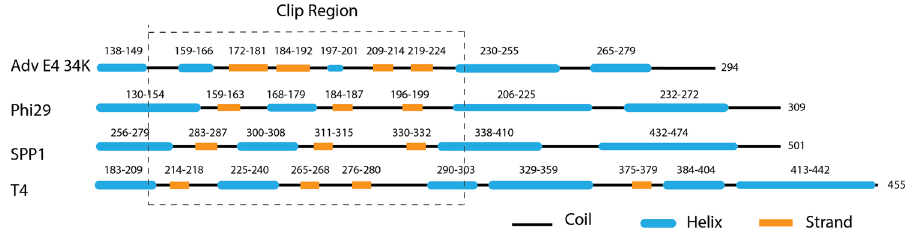
Figure 1. Comparison of predicted secondary structure of AdV E4 34K with the clip region of known portal proteins. The secondary structures of AdV E4 34K and three known portal proteins were predicted using PSIPRED and I-TASSER programs 40, 47 . Consensus structures are illustrated. The positions of the helices and strands are labeled above them. The predicted clip region is boxed with dash lines. The length of the predicted domain is approximately proportional to the length of the